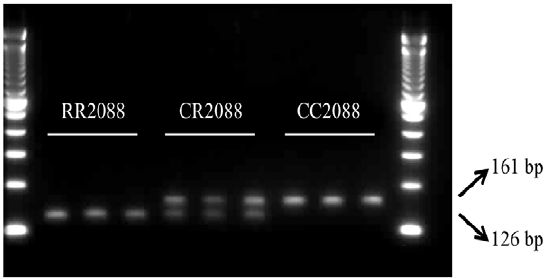
Figure 1. CAPS procedure for the detection of a thymine to cysteine change (C2088R mutation) at nucleotide position